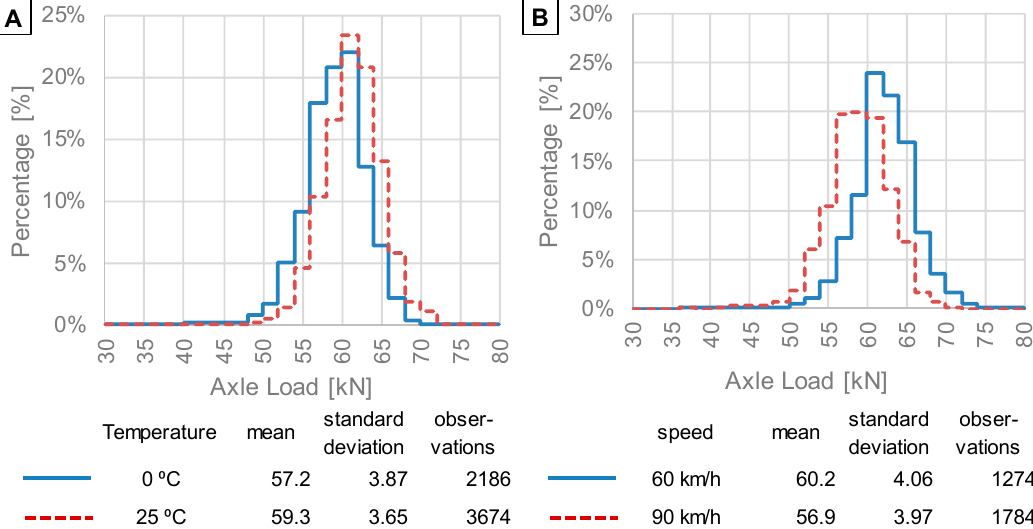
Figure 6. Example of the effect of bias of SALS determined for data from WIM station no. 58 and caused by: ( A ) differences in air temperatures; ( B ) differences in vehicle speed.